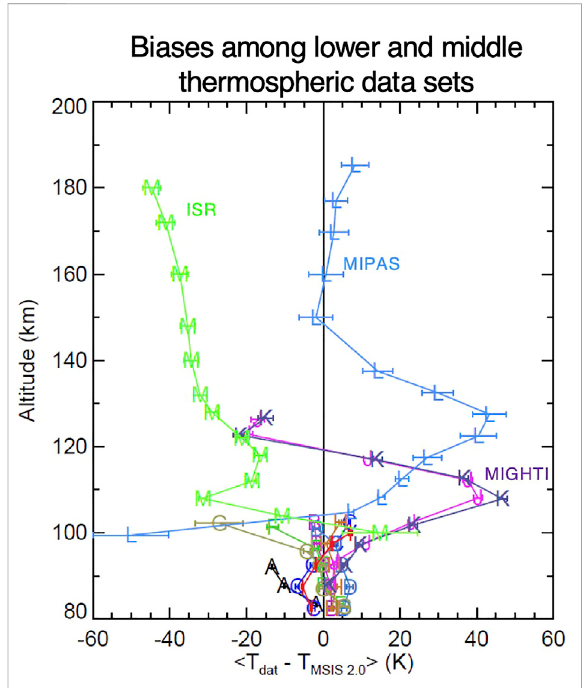
Biases among selected lower and middle thermospheric temperature datasets, during daytime and at mid-latitudes (30S — 47N) with respect to NRLMSIS 2.0 as the baseline. The middle thermospheric data sets MIGHTI ( “ J ” , “ K ″ ), MIPAS ( “ L ” ), and ground-based incoherent scatter radar (ISR, “ M ” ) are highlighted. The data sets below 100 km include a variety of space-based and ground-based remote sensing measurements. Error bars denote the statistical uncertainty of the estimated biases. Also shown but not discussed in are AURA/MLS ( “ A ” ), ACE/ FTS ( “ B ” ), UARS/HALOE ( “ C ” ), AIM/SOFIE ( “ D ” ), Boulder, CO Lidar ( “ E ” ), Ft. Collins, CO Lidar ( “ F ” ), Logan, UT Lidar ( “ G ” ), TIMED/SABER ( “ H ” ), and ODIN/OSIRIS ( “ I ”